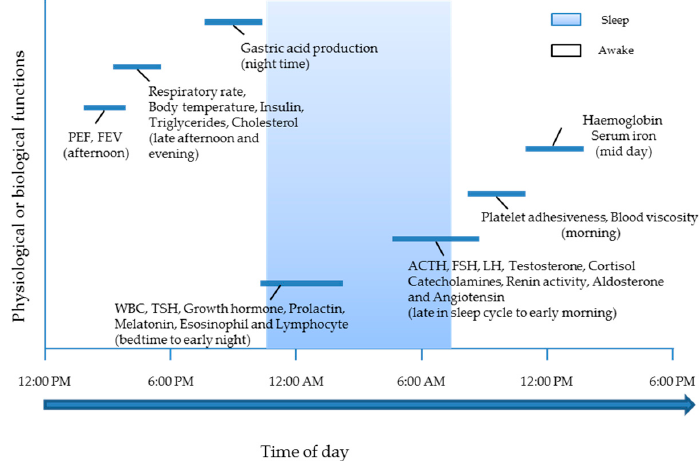
Figure 1. Time of day when physiological or biochemical functions are at peak [16,17]. PEF, peak expiratory flow rate; FEV, forced expiratory volume; WBC, white blood count; TSH, thyroid stimulating hormone; ACTH, adrenocortical tropic hormone; FSH, follicle stimulating hormone; LH, luteinizing hormone.